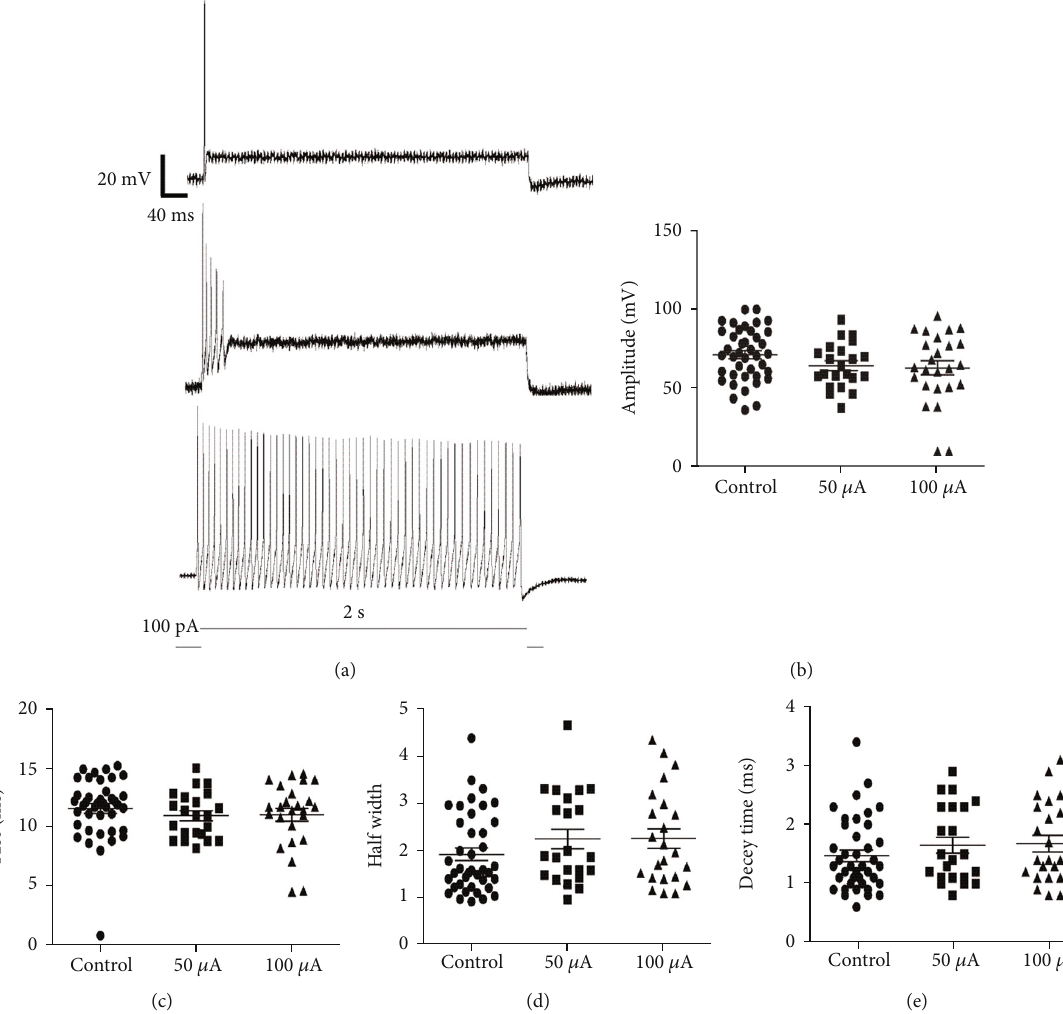
Figure 3: In fl uence of electrical stimulation on the fi ring characteristics of SGNs. (a) Type I neuron had only one action potential after electrical stimulation, type II had 2 ~ 6 action potentials, and type III could continue fi ring APs during the test pulse. (b – e) AP amplitude, latency, and duration had no statistically signi fi cant di ff erences in all three groups ( p > 0 : 05